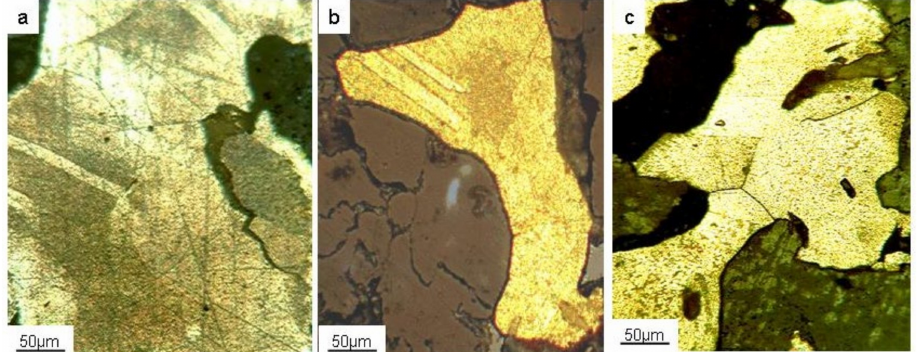
Figure 4. Polygonal-granular structure of native gold with simple twins in ores of various deposits of gold–arsenic-sulfide GIT: ( a ) Natalka, ( b ) Degdekan, ( c ) Maldyak.